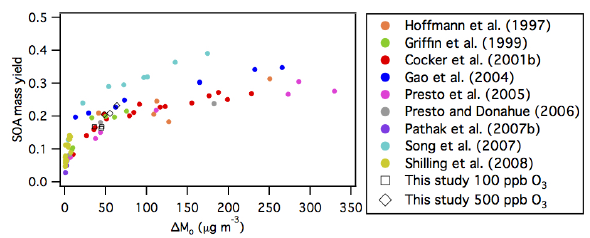
Figure 5. Comparison of SOA mass yields obtained in this study to those of previous dark α -pinene ozonolysis studies (Table S3). The SOA mass yields and concentrations of majority of these previous studies (Hoffmann et al., 1997; Griffin et al., 1999; Cocker et al., 2001b; Gao et al., 2004; Presto et al., 2005; Presto and Donahue, 2006; Pathak et al., 2007b; Song et al., 2007) were previously com- piled by Shilling et al. (2008). Similar to Shilling et al. (2008), all the data shown here (including those reported in this study) have been adjusted using an organic density of 1.0gcm − 3 , and to 298K using a temperature correction of 1.6%K − 1 , as recommended by Pathak et al. (2007b) to facilitate easier comparison among the dif- ferent